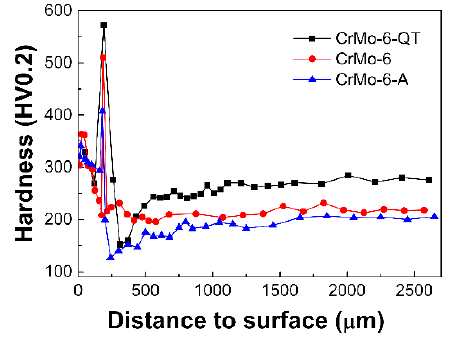
Figure 7. Microhardness distribution along the depth direction of various samples.